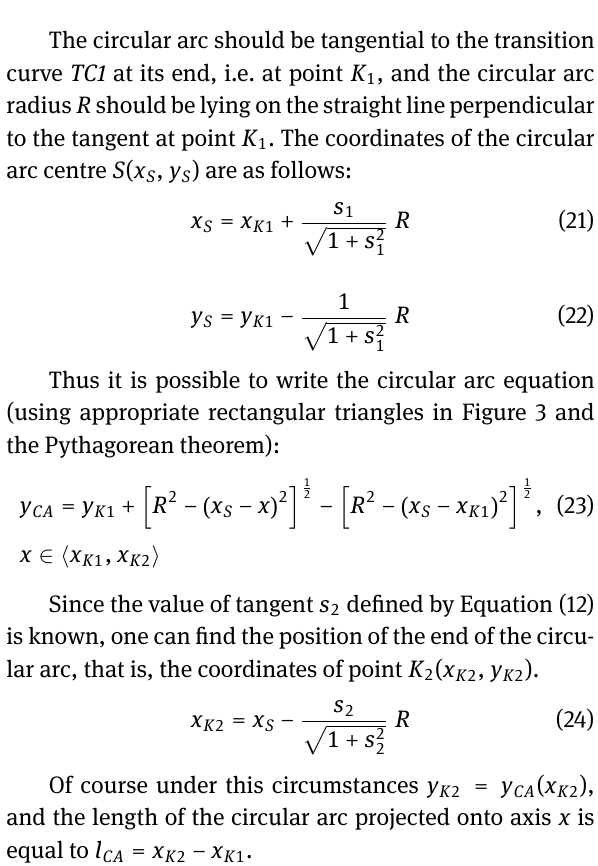
The circular arc should be tangential to the transition curve TC1 at its end, i.e. at point K 1 , and the circular arc radius R should be lying on the straight line